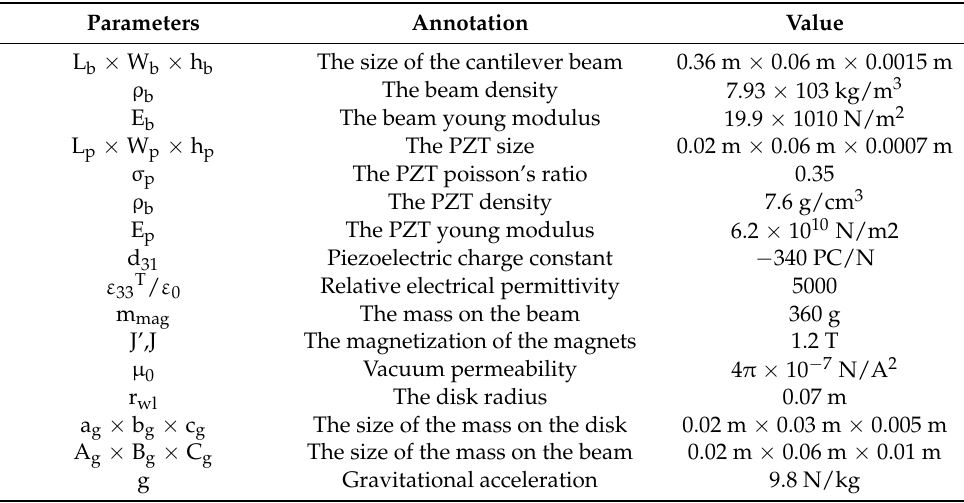
Figure 4. Torque of the water to the shaft corresponding to inclination angle ( θ ). Table 2. Main parameters of energy harvesting application using the hybrid